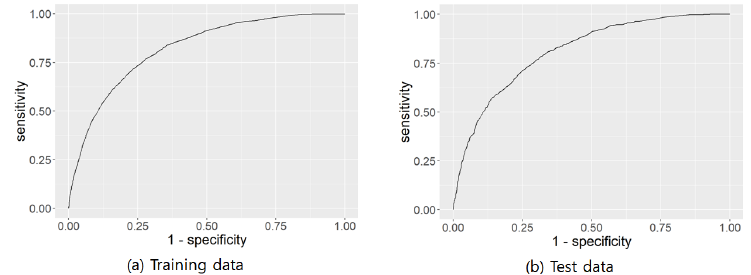
Figure 2. ROC curve validation of a nomogram for metabolic syndrome.